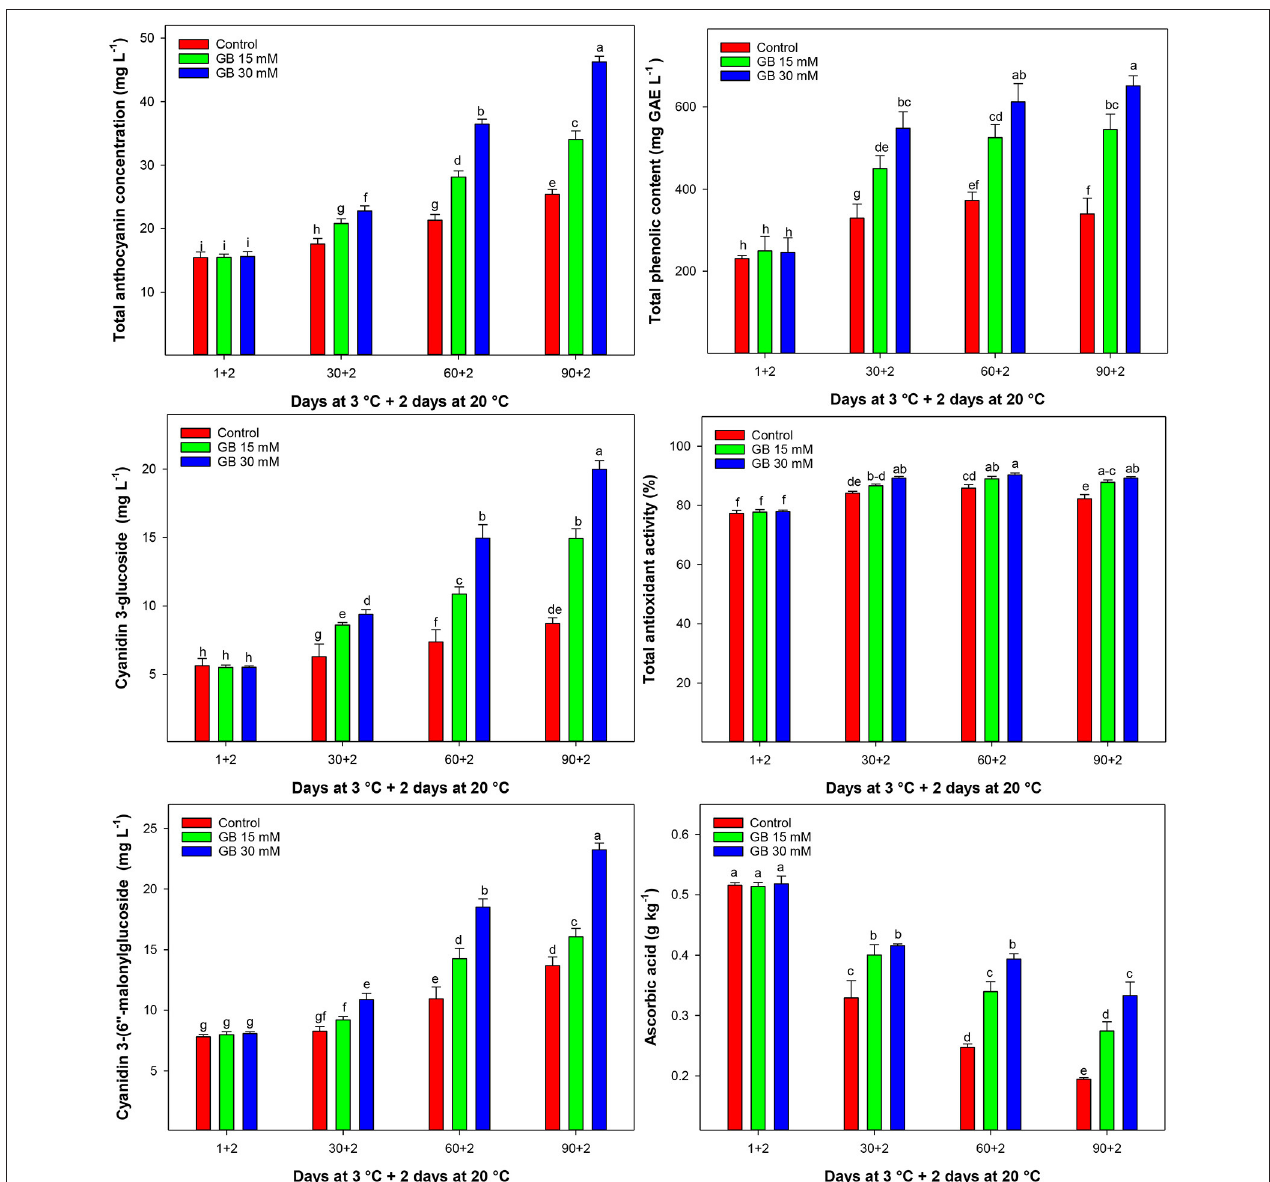
FIGURE 5 | Changes in total anthocyanin concentration (TAC), cyanidin-3-glycoside, cyanidin 3-(6 ′′ -malonylglucoside), total phenolic content, total antioxidant activity (TAA), and ascorbic acid in control and GB-treated of “Moro” blood orange at 3 ◦ C. Different letters and vertical bars show significant difference ( p < 0.05) and standard errors ( ± SE) of means,